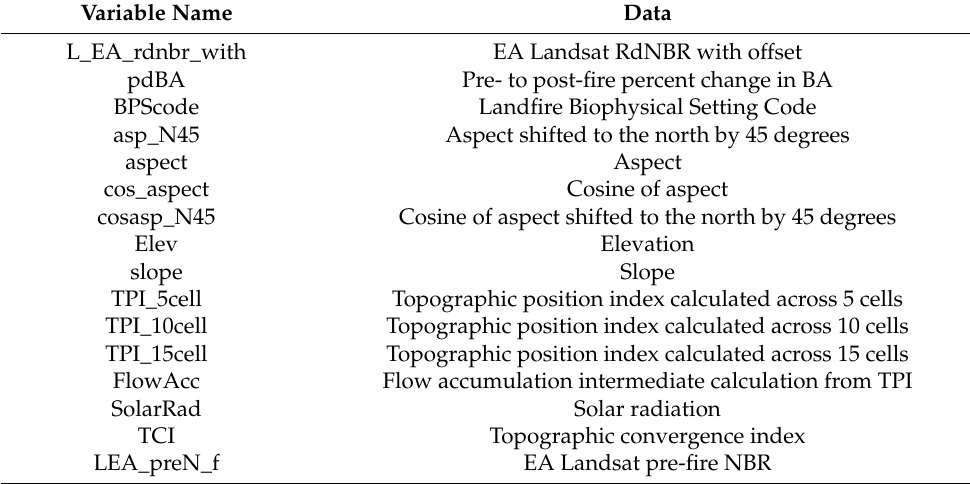
Table A5. Dictionary of variables used in random